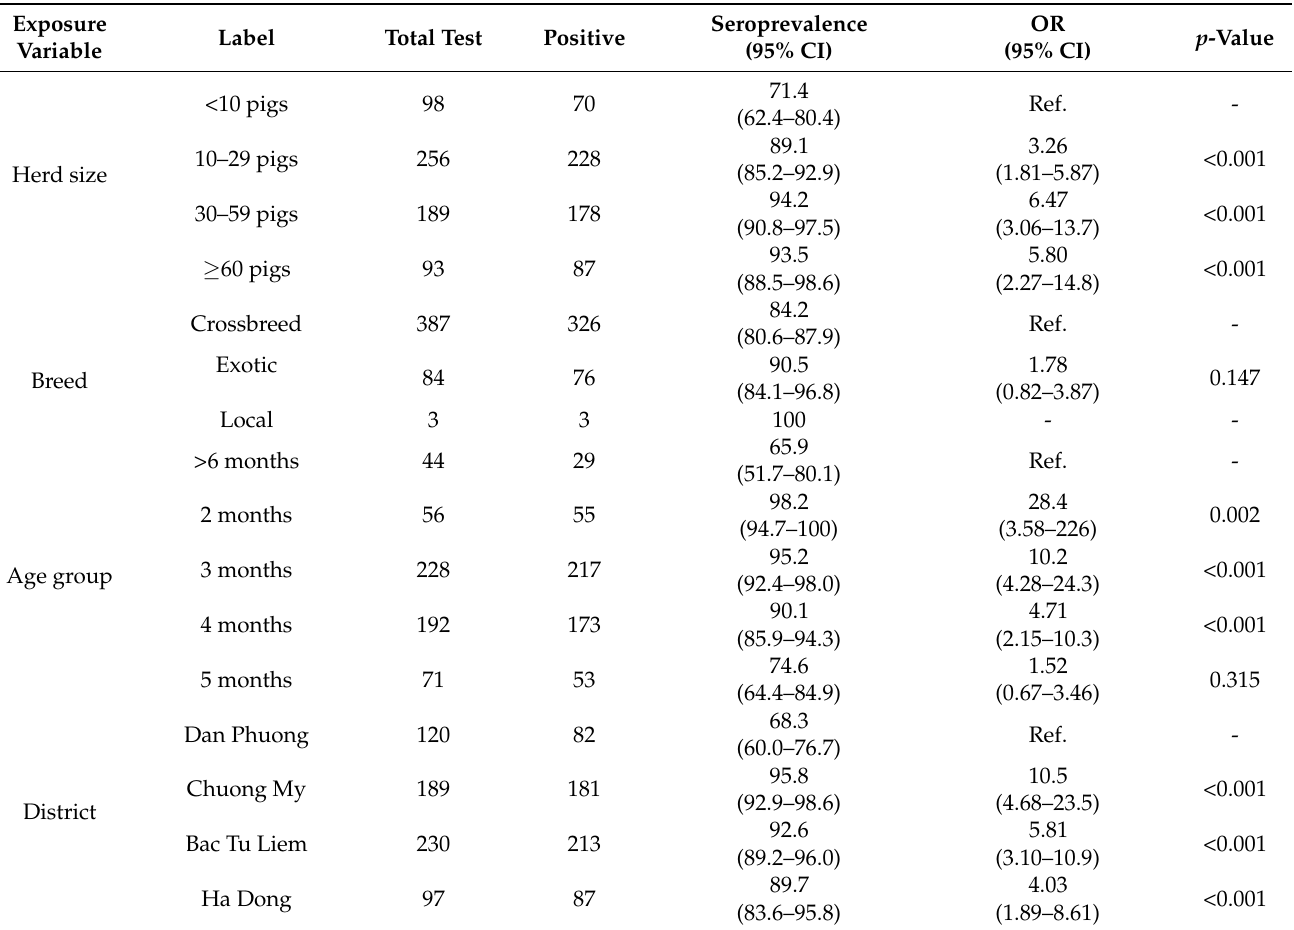
Table 9. Results from univariable analysis showing the association between seropositivity of pigs and exposure